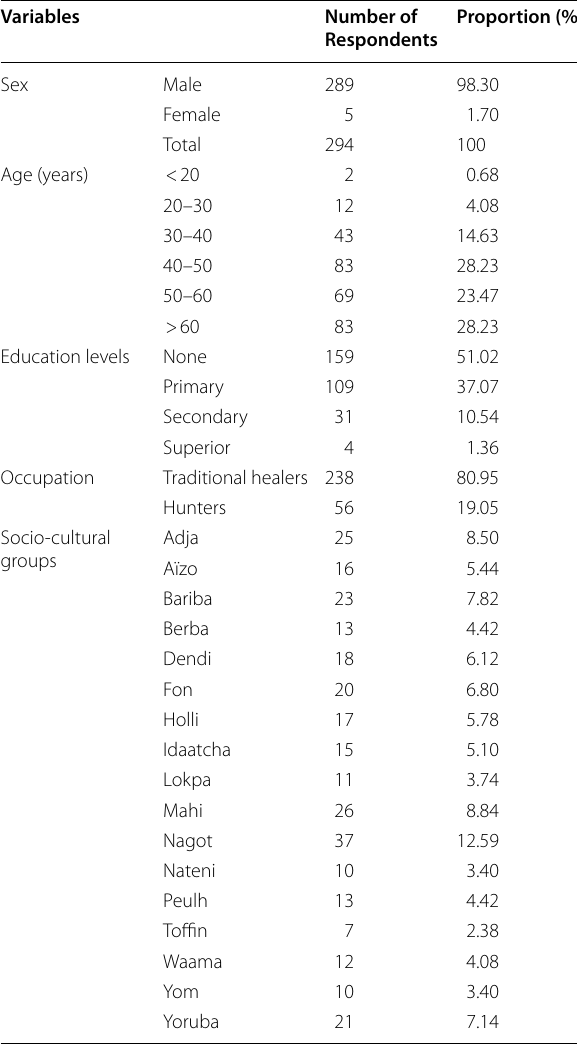
Table 3 Indices of diversity of plant species used to prevent